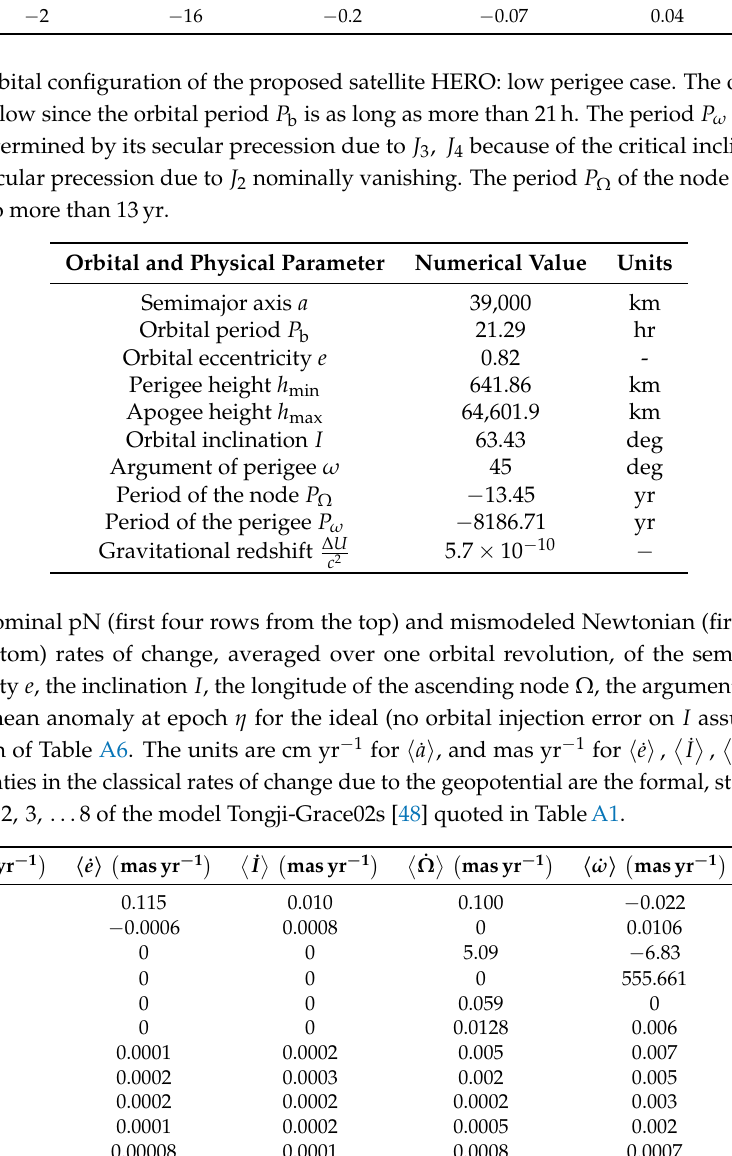
Table A5. Numerically integrated nominal rates of change, averaged over one orbital revolution, of the semimajor axis a , the eccentricity e , the inclination I , the longitude of the ascending node Ω , the argument of pericenter ω , and the mean anomaly at epoch η induced by the neutral atmospheric drag for the orbital configuration of Table A2. The units are m yr − 1 for (cid:104) ˙ a (cid:105) , and mas yr − 1 for = (cid:104) ˙ e (cid:105) , (cid:10) ˙ I (cid:11) , (cid:10) ˙ Ω (cid:11) , (cid:104) ˙ ω (cid:105) , (cid:104) ˙ η (cid:105) . For the satellite, assumed spherical in shape and passive, we adopted C D 3.5, Σ = 2.69 × 10 − 4 as for the existing LARES [53]. In regard to the Earth’s neutral atmospheric density, we adopted r 0 = r min = a ( 1 − e ) = 1046.86km, ρ 0 = ρ max = ( 7.3 − 2.8 ) × 10 − 15 kgm − 3 , ρ min = 0.001 ρ L , λ = 872.87km − 938.49km; the neutral atmospheric density at the height of LAGEOS is ρ L = 6.579 × 10 − 18 kgm − 3 [54]. See AppendixC for details. Neither approximations in e nor in . = Ψ / n = ρ max was kept fixed over one orbital revolution. Cfr. with the ν b were used. The value of ρ 0 analytical plots in FigureA1 and the numerically produced time series in FigureA2.